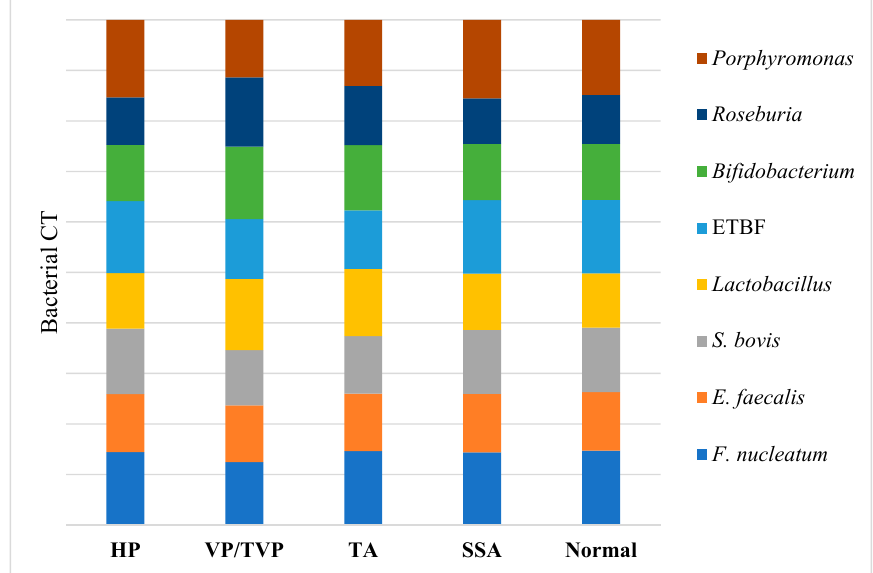
Figure 2. Distribution of targeted bacterial markers between hyperplastic polyp (HP), villous / tubulovillous (VP / TVP), tubular adenoma (TA), sessile serrated adenoma (SSA), and normal groups were depicted in horizontal axis. In addition, bacterial CT of Porphyromonas spp., Roseburia spp., Bifidobacterium spp., Enterotoxigenic Bacteroides fragilis (ETBF), Lactobacillus spp., Streptococcus bovis , Enterococcus faecalis , and Fusobacterium nucleatum were demonstrated in vertical axis. Higher amounts of F. nucleatum , E. faecalis , S. bovis , ETBF, and Porphyromonas spp. based on CT analysis were detected in patients’ samples with TAs and VP / TVPs ( p -value < 0.001), while higher abundance of Lactobacillus , Roseburia , and Bifidobacterium were reported in normal, HP, and SSA ( p -value <